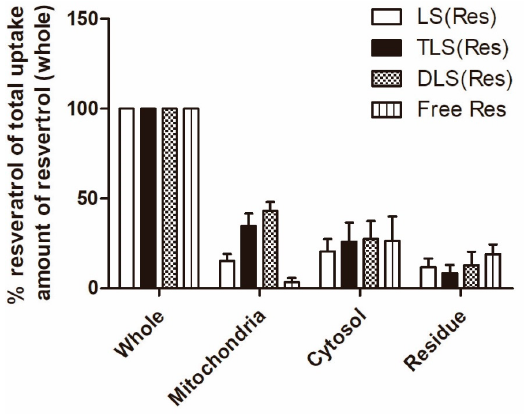
Figure 8. Intracellular uptake of LS (Res), TLS (Res), DLS (Res) and free resveratrol by B16F10 cells after 1 h of incubation. The data represent the mean ± S.E.M ( n = 3).